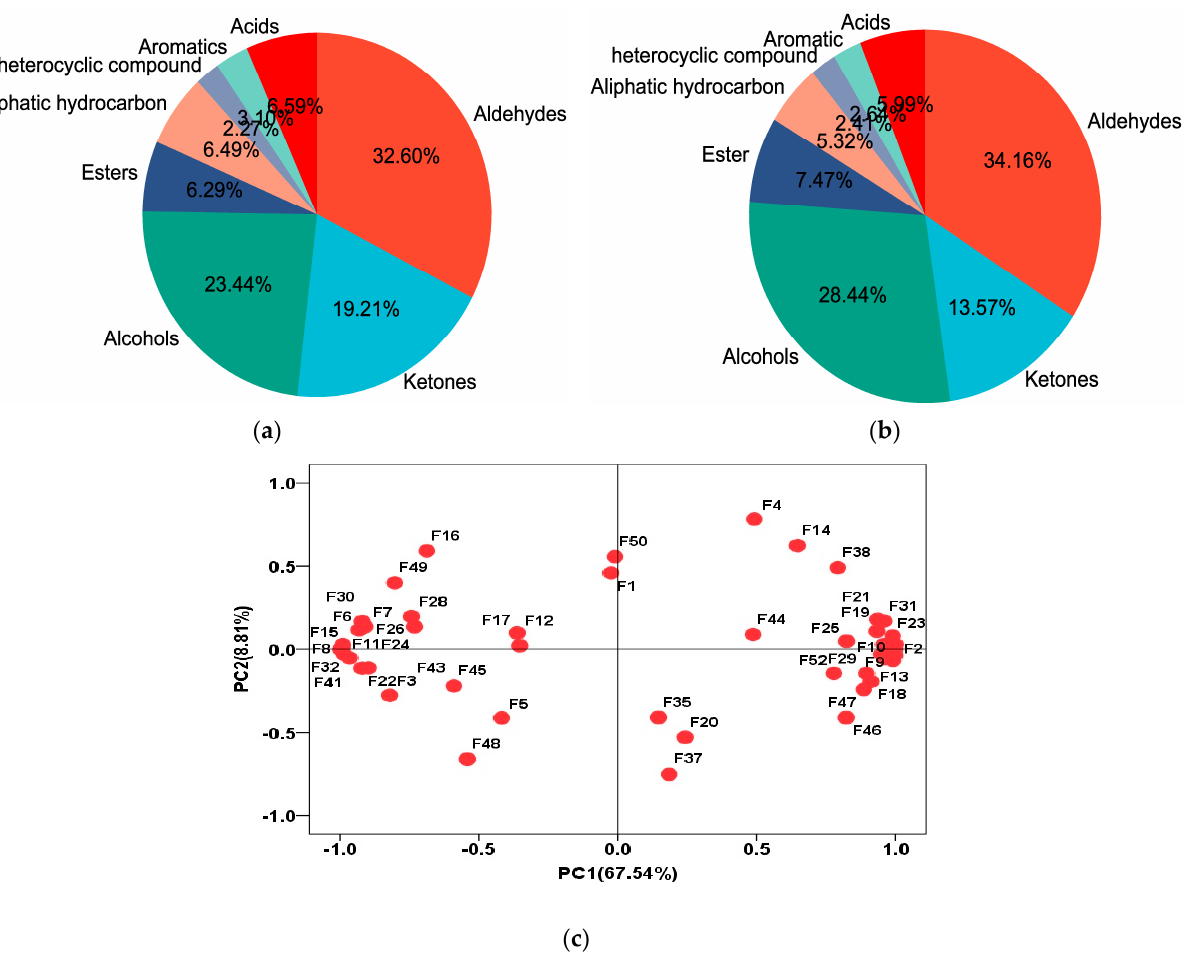
Figure 4. ( a ) The composition of various volatile flavor compounds in the yak LD under GF. ( b ) The composition of various volatile flavor compounds in the yak LD under SF. ( c ) The Loading-PAC of volatile flavor compounds in all yak LD samples.